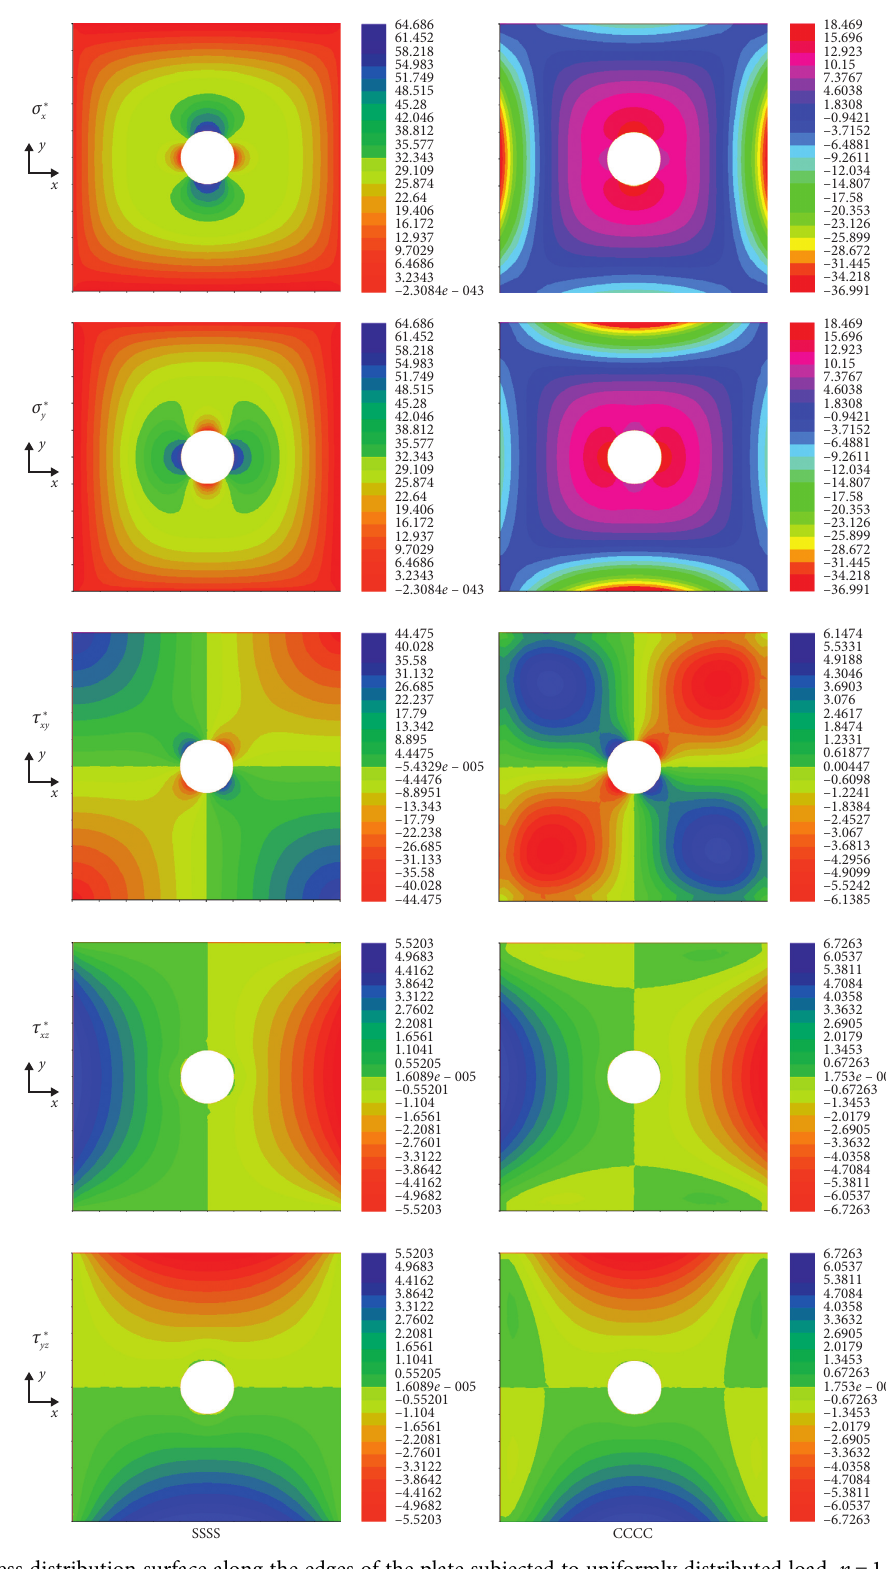
Figure 8: The stress distribution surface along the edges of the plate subjected to uniformly distributed load, n � 1, a / h � 10, a / b � 1, and ψ �